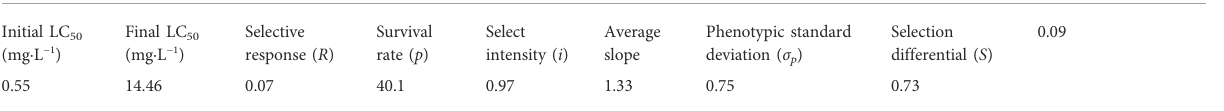
TABLE 2 Realized heritability of SBPH to